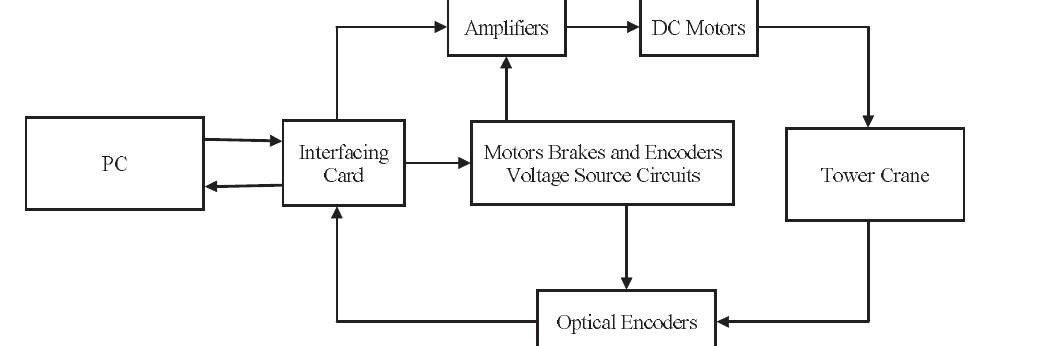
Fig. 12. Experimental setup diagram.